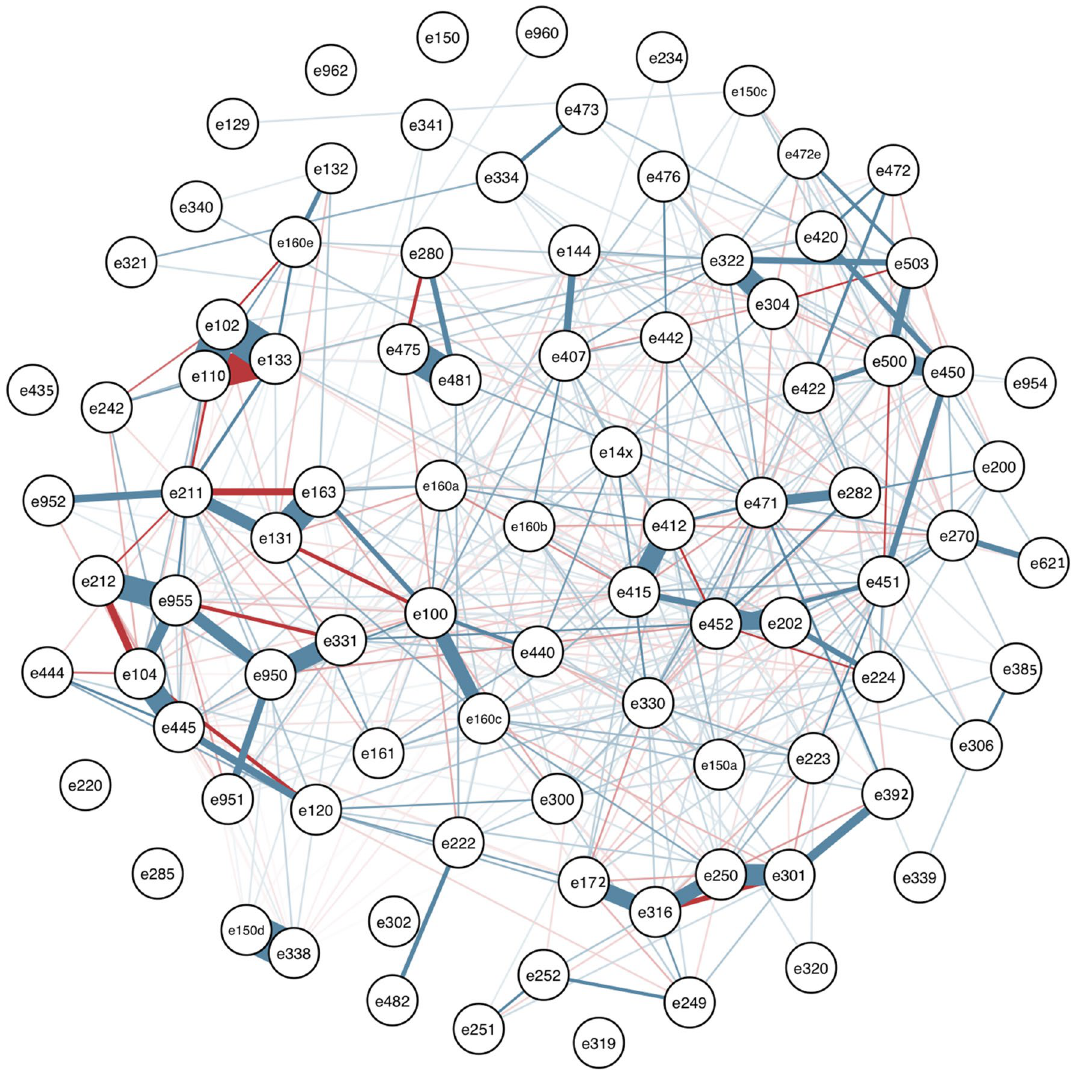
Figure 2. Network of partial correlations between food additive intakes, NutriNet-Santé cohort, France, 2009–2020 (N = 106,489). Graphical lasso. Glasso package. Generated for the selected food